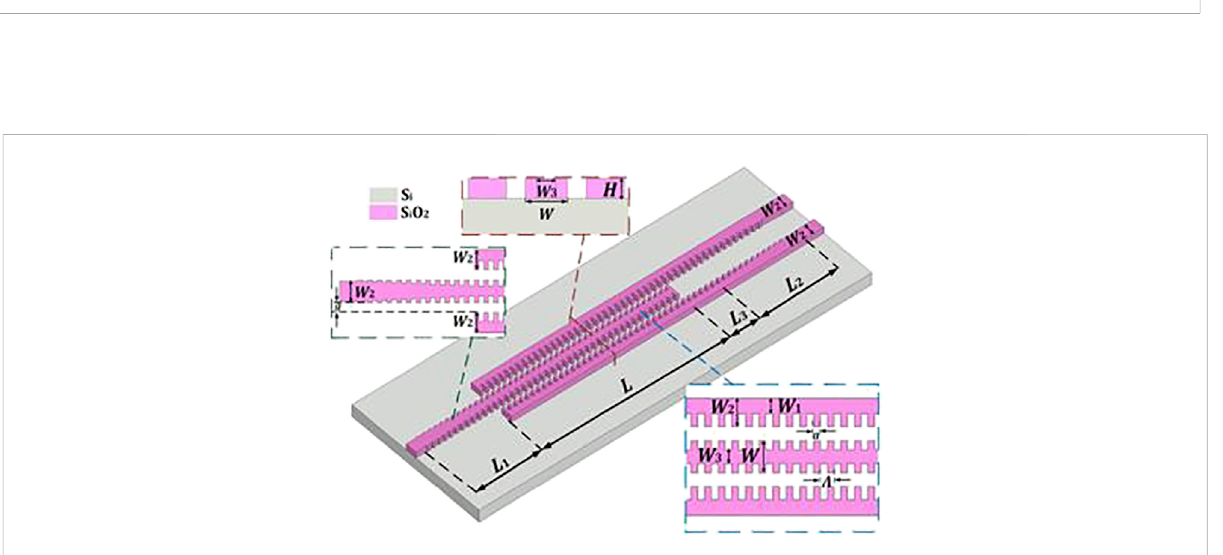
FIGURE 5 Optimal design of symmetrical DC. DC with bridged silicon waveguide etched with subwavelength grating [118]. Figure reproduced with permission from: © 2020, Elsevier.